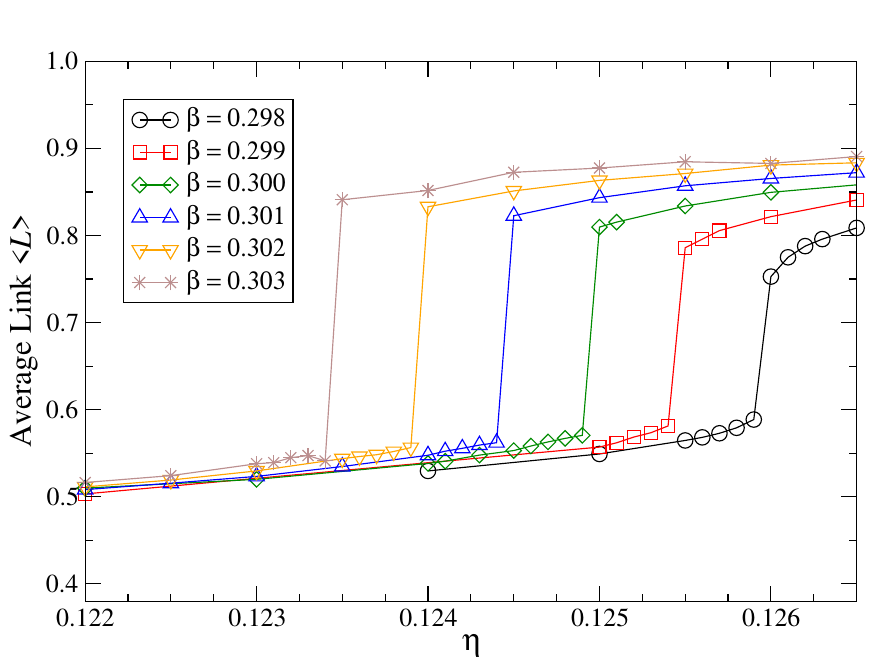
Figure 11 . η dependence of h L i at µ = 2 for β ∈ [0 . 298 , 0 . 303]